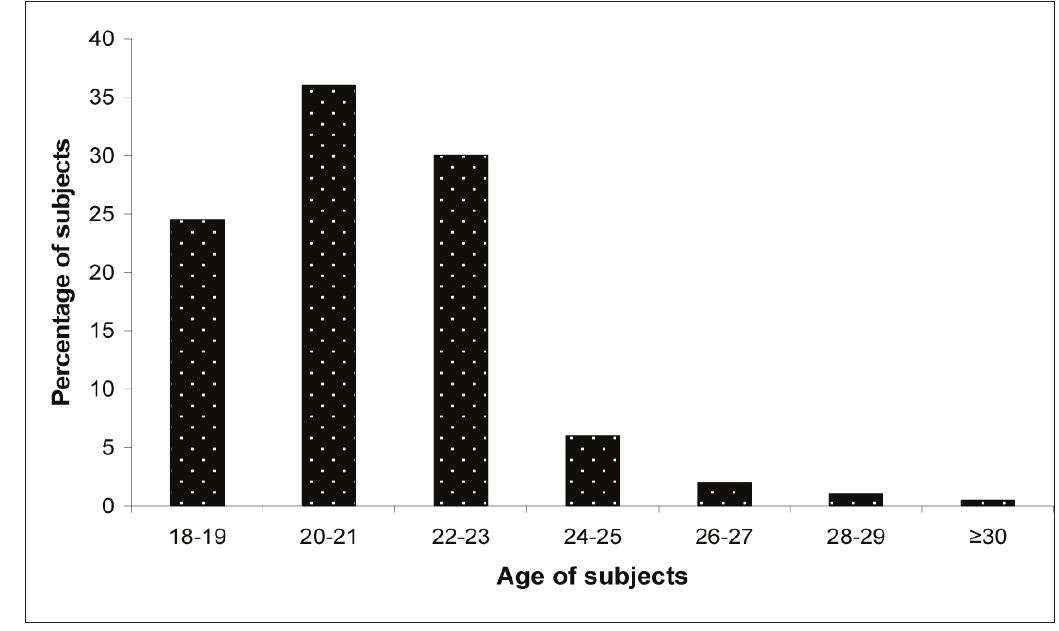
Figure 2: The age distribution of the subjects included in the study. A one-sample Kolmogorov-Smirnov Test (a non-parametric test) was done for average values of IOP, systolic BP and diastolic BP and it was found that data was normally distributed ( p > 0.05). The Pearson correlation coefficient for average IOP and systemic BP was 0.67 with a probability value of < 0.05. With an increase in average systolic BP there is an increase in the average IOP. The relationship between average IOP and average systolic BP is shown in Figure 3.